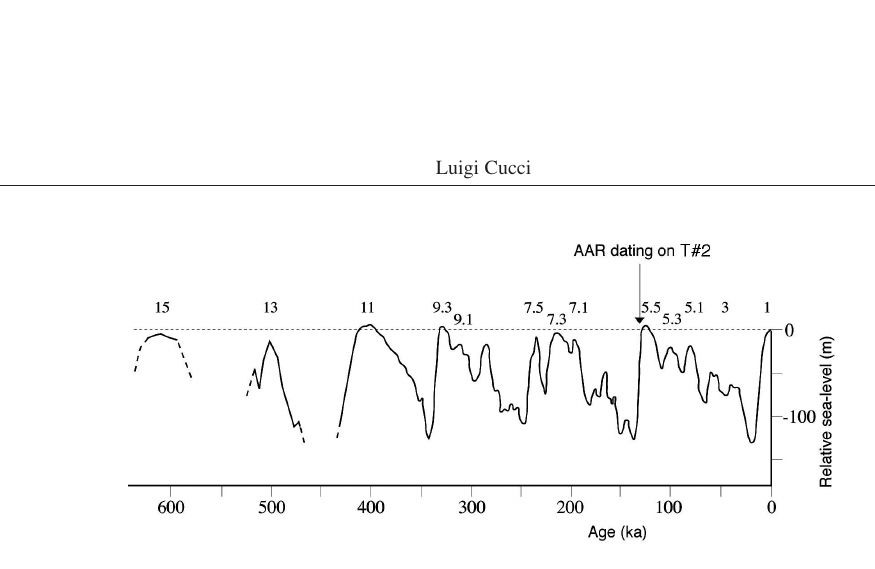
Fig. 8. Paleo-sea level curve during the past 0.6 Myr. The numbers denote marine isotopic stages. Data of rel- ative sea-level from MIS 11 onward are from Waelbroeck et al. (2002), older data are from Lajoie et al. (1991). Measured AAR dating on T#2 is also